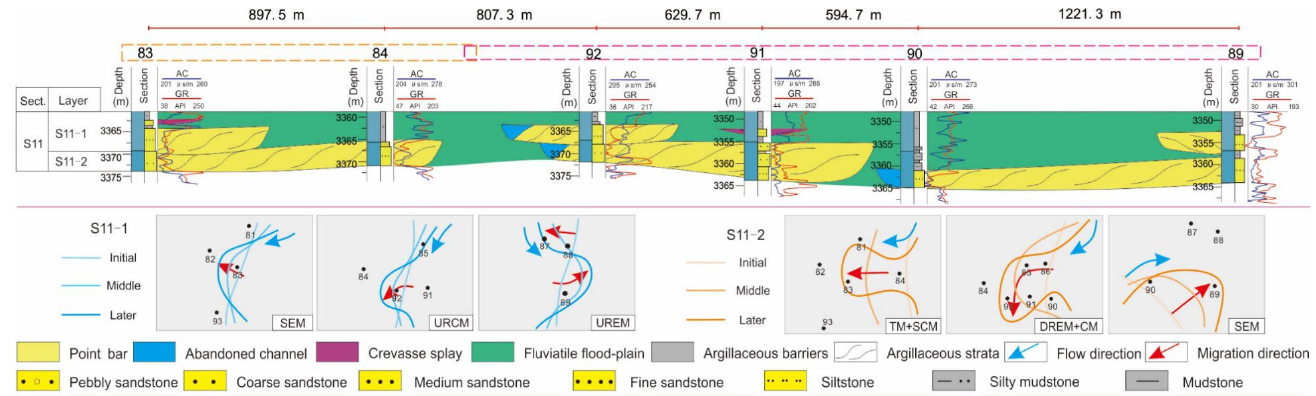
Figure 18. Profile T11 of comprehensive analysis including evolution model of meander bend-based multiple connected core wells which are collected from database in S 11 sublayer of Su-X block, Sulige gas field, Ordos Basin, China: migration areas Z3 (yellow frame), Z4(gray frame).